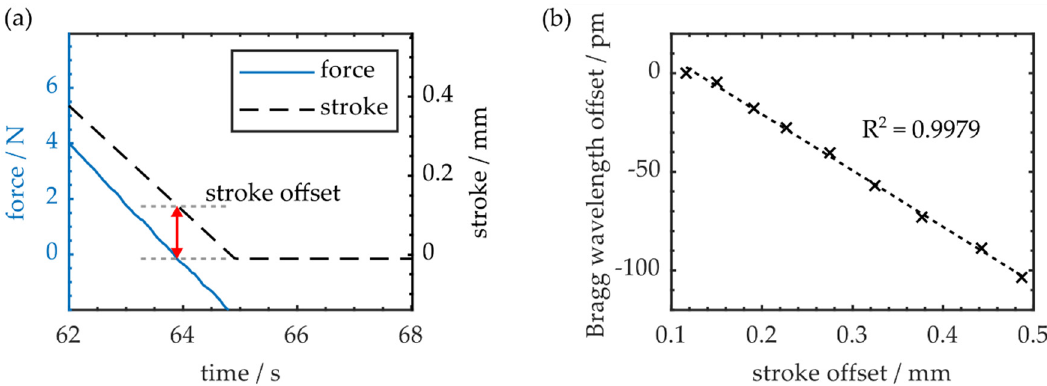
Figure 5. ( a ) Stroke offset due to plastic deformation at the end of a three-point flexural cycle; ( b ) Resulting Bragg wavelength offset as a function of stroke offset.